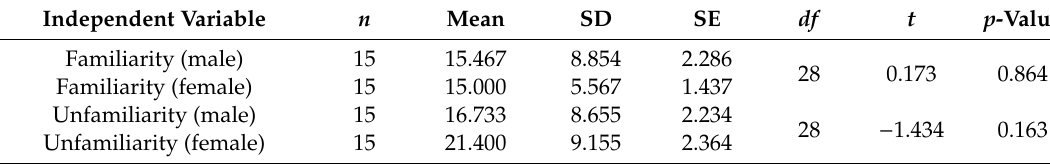
Table 15. Independent t -test results for gender in the number of web page surfed. Independent